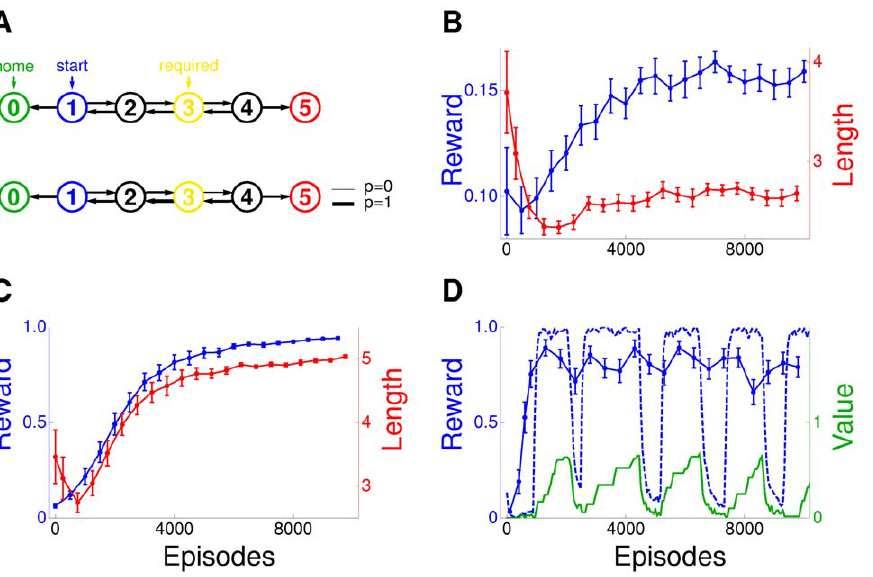
Figure 5. Sequential decision making. (A) Top row, sketch of the path finding task. Bottom row, example stochastic policy learned by the population when decisions are based on just the current position, arrow thickness represents probability of transition. (B) Evolution of the average reward per episode (blue) and the average number of steps per episode (red) for population learning with decisions based on current position. (C) Same as in (B), but for population learning with decisions based on the current and previous position. The above population simulations used N ~ 67 and t R ~ 3s . (D) TD-learning with decisions based on the current and previous position. Average reward per episode (solid blue curve) and reward per episode in a typical single run (dotted blue). For this run, the green curve shows the evolution of the value assigned by the TD-learner to making a shortcut, i.e. to the state action pair ( 1 2, left ). Error bars show 1 SEM of the mean.